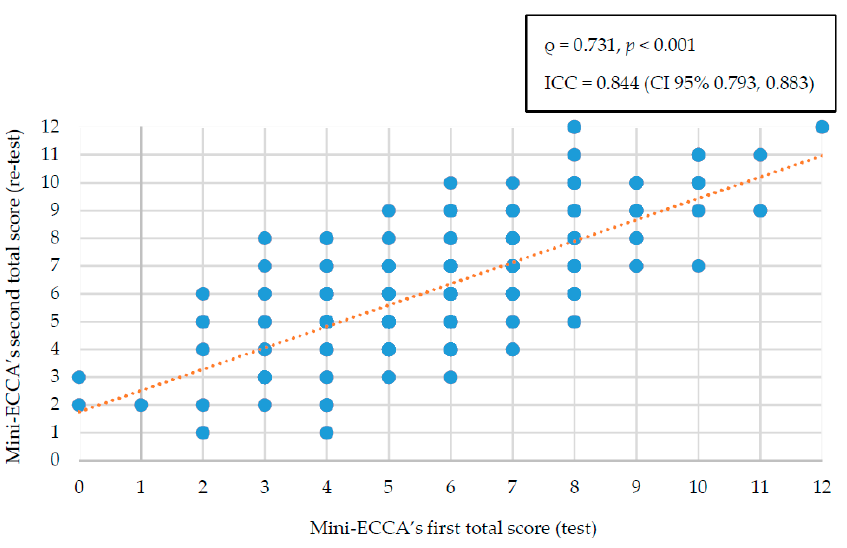
Figure 1. Reproducibility of the total scores obtained in the test–retest. ICC: intra-class correlation coefficient. CI: confidence interval. Table 4. Concordance of the food intake quality classification, according to the total Mini-ECCA score ( n = 206).